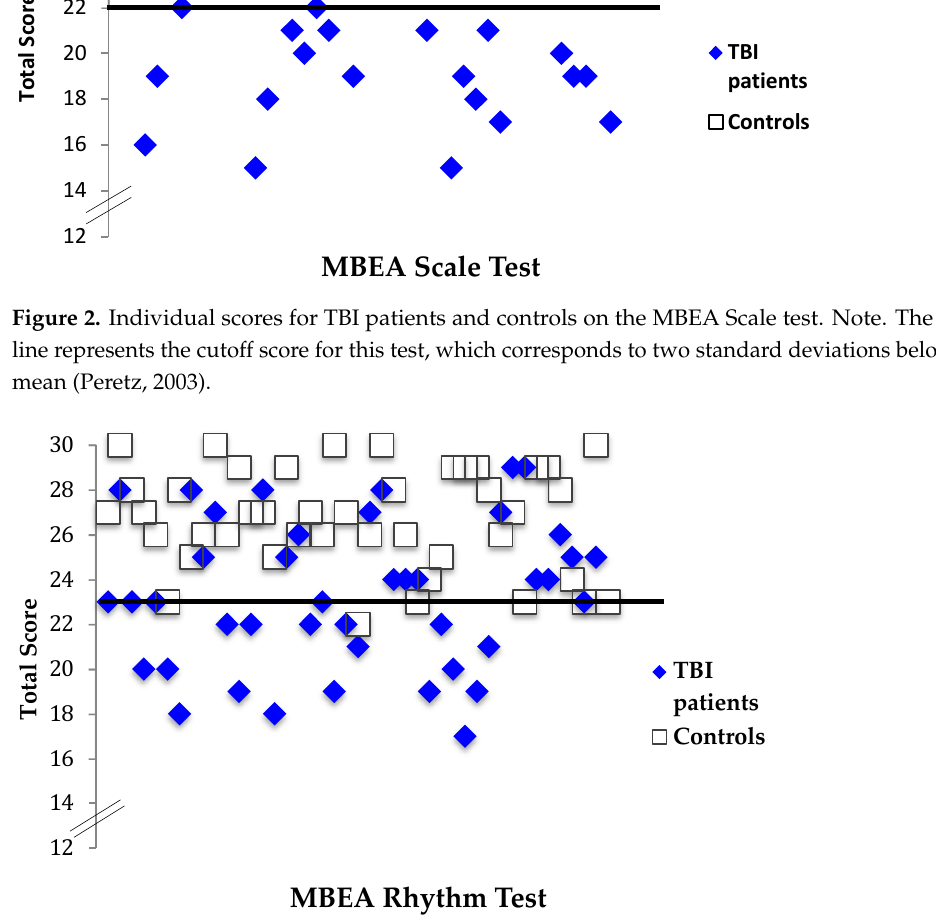
Figure 2. Individual scores for TBI patients and controls on the MBEA Scale test. Note. The black line represents the cutoff score for this test, which corresponds to two standard deviations below the mean (Peretz, 2003).